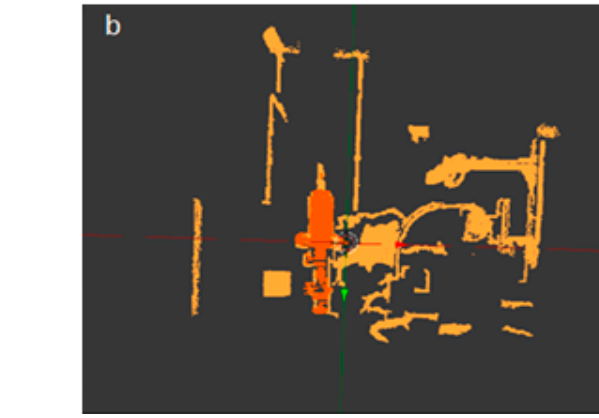
Figure 8. ( a ) Contour method; ( b ) surface-matching method.